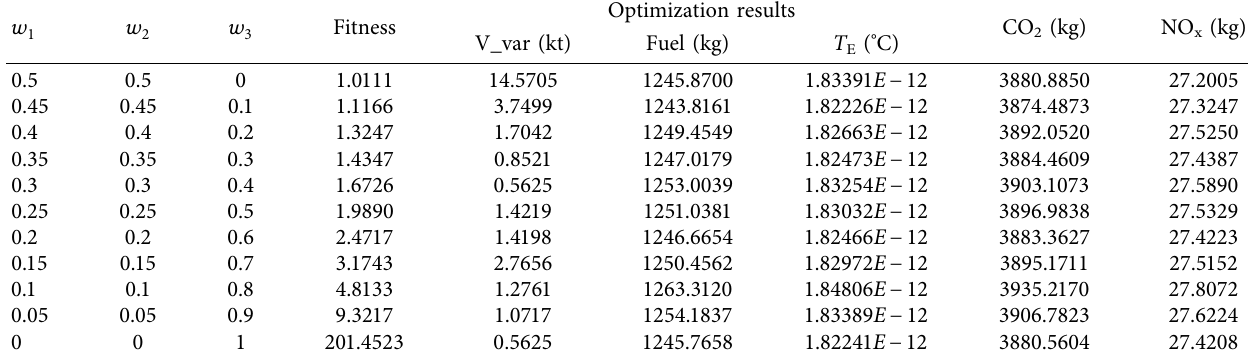
Table 3: Different weight combinations and optimization results.